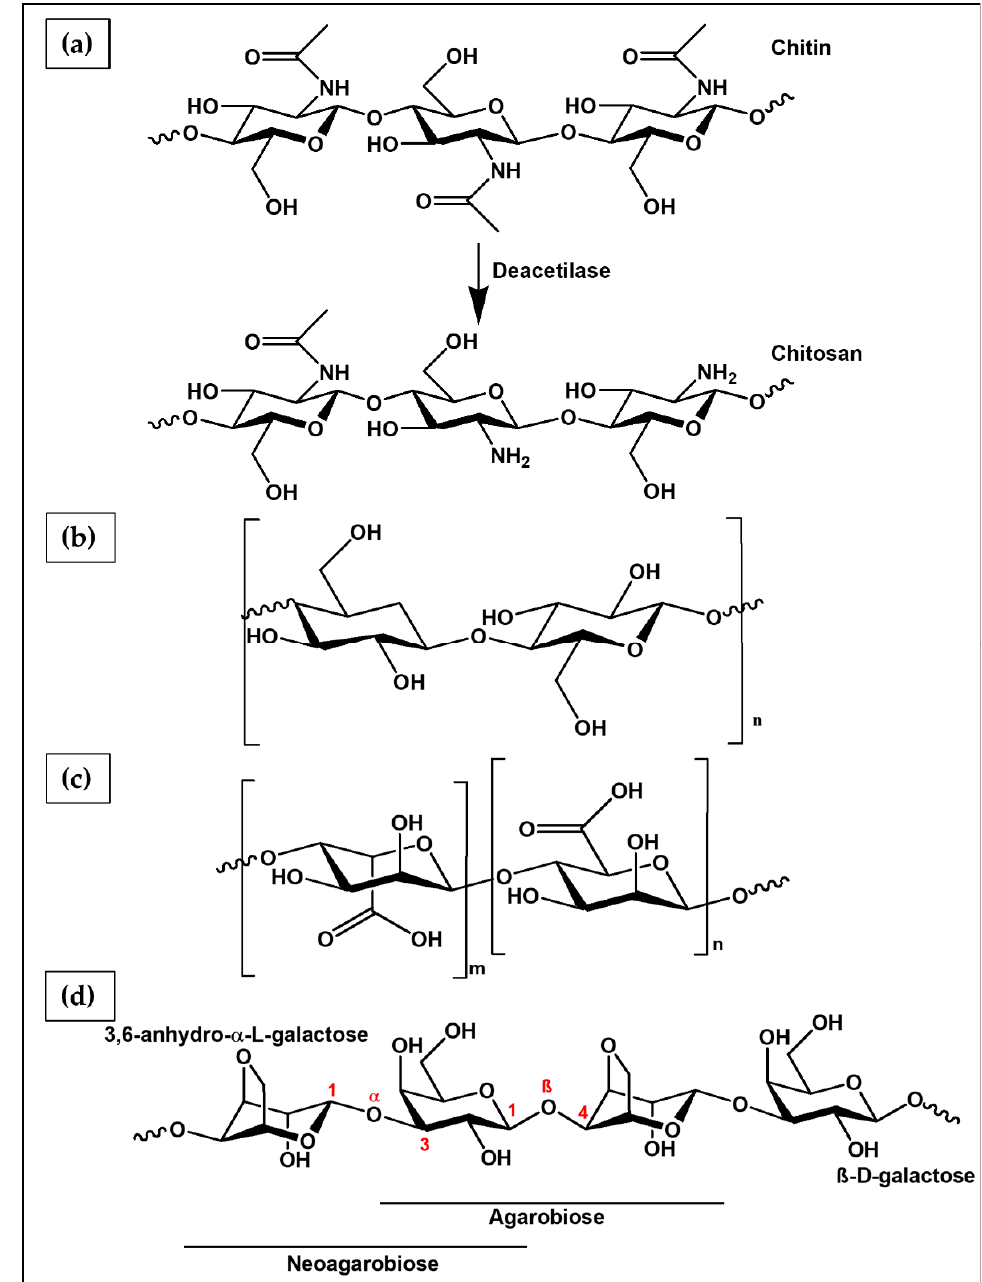
Figure 8. Chemical structure of polysaccharides investigated for hydrogel-based scaffolds in OC modeling. ( a ) Chitosan obtained by chitin denaturation, ( b ) cellulose, ( c ) alginate, and ( d ) agarose. Kletzmayr et al. [197] developed a chemically modified alginate derivative through an oxidation process (oxAlg) to form hydrogels via chemical crosslinking with N-succinyl- chitosan (sChi). The developed hydrogel, obtainable inside the 96-well plates classically used in 2D cell culture studies, was able to support the growth of ovarian, lung, and